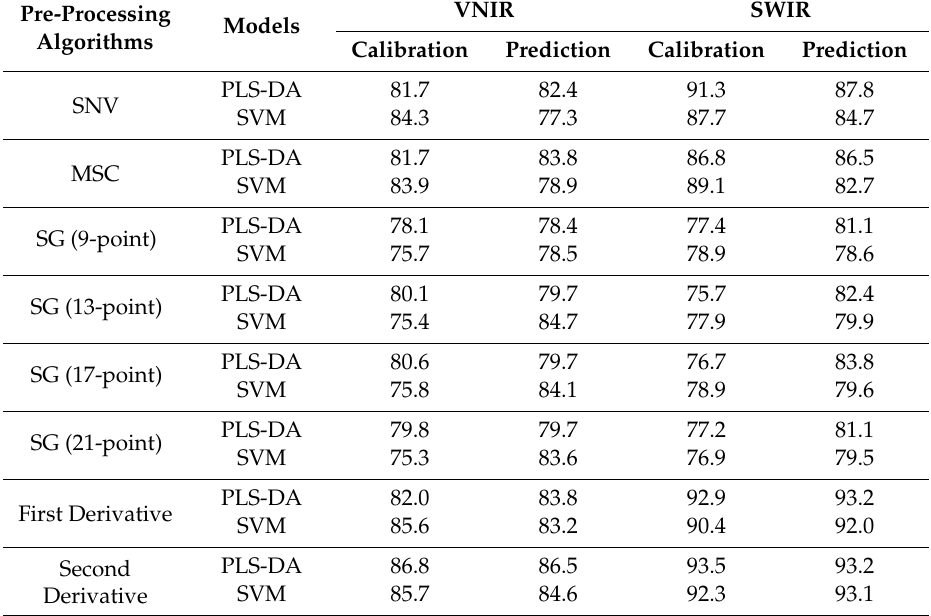
Table 1. The classification accuracies (%) of pairwise combinations of pre-processing algorithms and classification models in both VNIR and SWIR